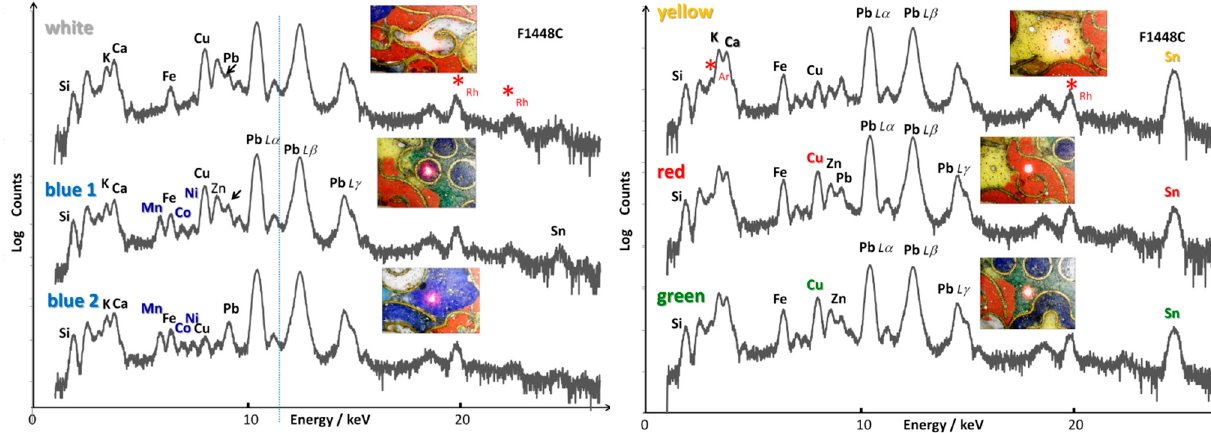
Figure 5. Representative pXRF spectra recorded on the different colored cloisonné enamels of the incense burner (white, blue, yellow, red and green areas). Red stars (*) indicate the contribution of the instrument (Rh peaks).